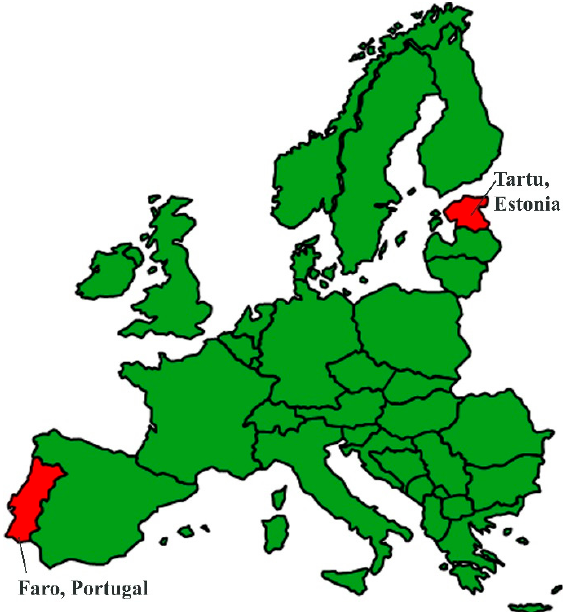
Figure 2. Location of Tartu, Estonia; and Faro, Portugal.